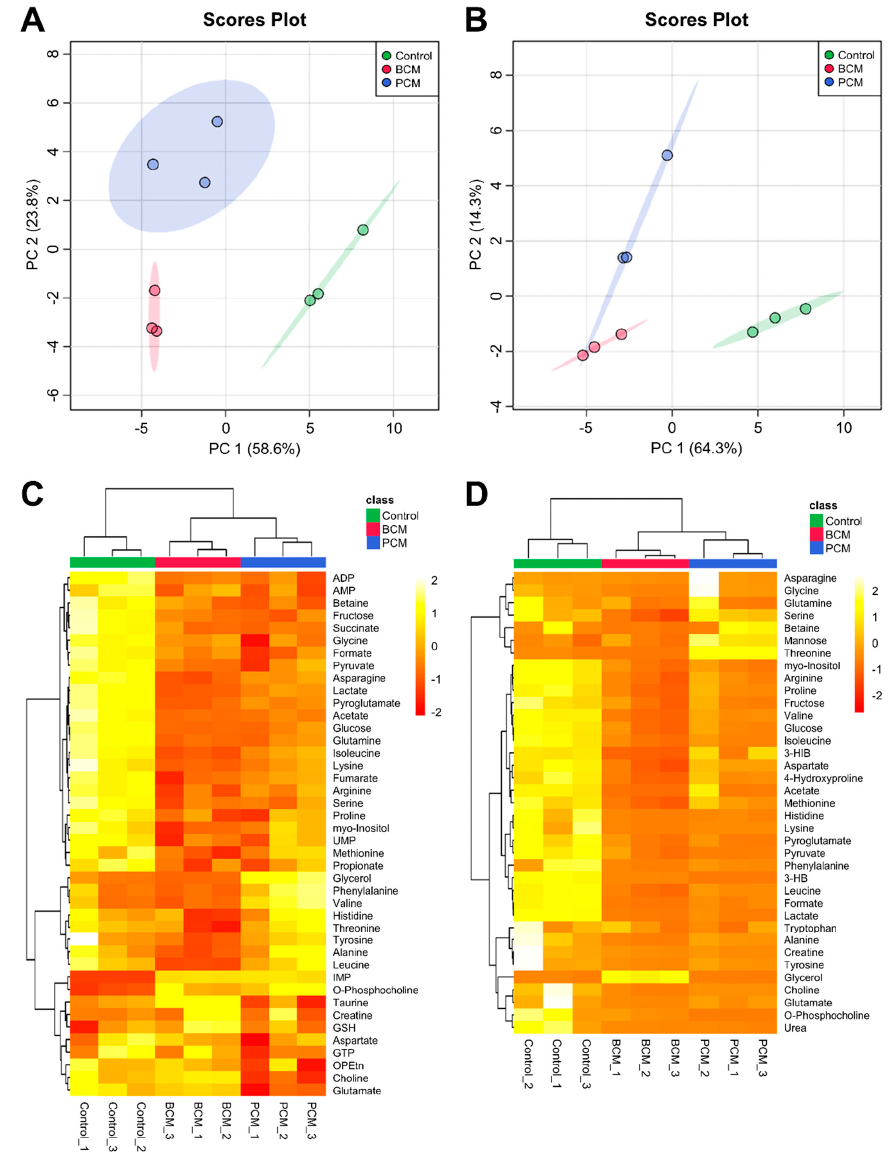
Figure 2. Multivariate statistical analysis of intra- and extracellular metabolomes derived from M Φ s exposed to PCM, BCM, and control media. Two-dimensional principal component analysis (2D-PCA) scores plots generated by analysis of metabolic profiles from ( A ) intra- and ( B ) extracellular M Φ metabolite extracts (control, green; BCM-exposed, red; PCM-exposed, blue), with shaded regions illustrating respective 95% confidence intervals. Heat map visualization and hierarchical clustering analysis (HCA) of metabolic profiles from ( C ) intra- and ( D ) extracellular M Φ metabolite extracts were conducted using a Euclidean distance measure calculated from metabolite abundance and a Ward clustering algorithm. The top column bar is colored according to experimental M Φ group (control, green; BCM-exposed, red; PCM-exposed, blue), and the color scale represents the scaled abundance of each metabolite, with pale yellow indicating high abundance and deep red indicating low abundance. Abbreviations denote: 3-HB, 3-hydroxybutyrate; 3-HIB, 3-hydroxyisobutyrate; ADP, adenosine diphosphate; AMP, adenosine monophosphate; BCM, biofilm-conditioned media; GSH, reduced glutathione; GTP, guanosine triphosphate; IMP, inosine monophosphate; OPEtn, o-phosphoethanolamine; PCM, planktonic-conditioned media; UMP, uridine